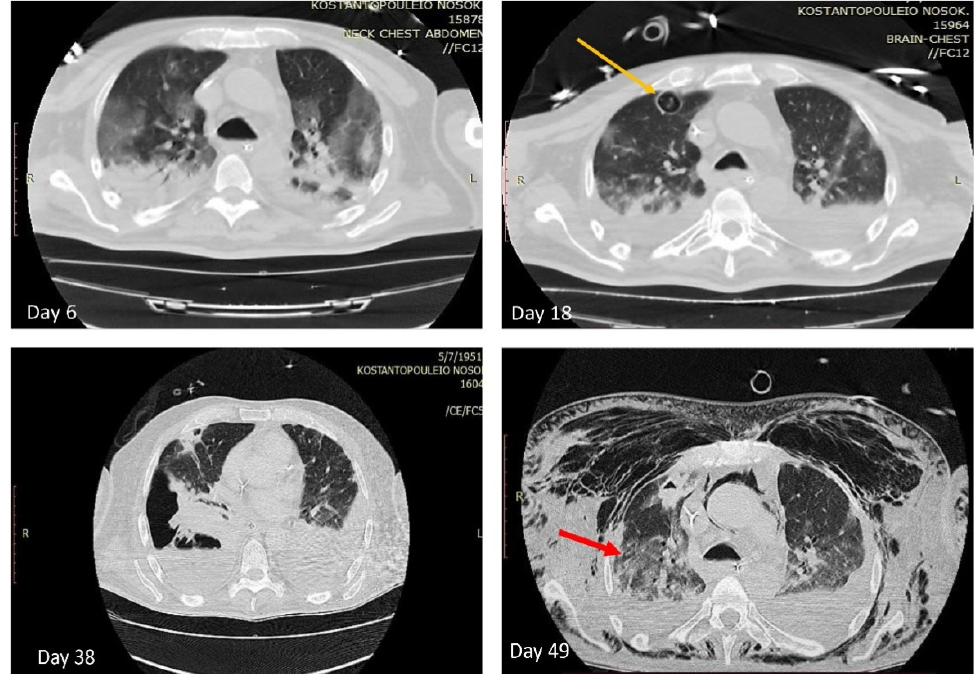
Figure 2. Chest computed tomography (CT) showing multi-lobar peripheral ground-glass opacities and consolidations (day 6); the yellow arrow depicts one cavitary lesion (day 18); the red arrow depicts the bronchopleural fistula (day 49).